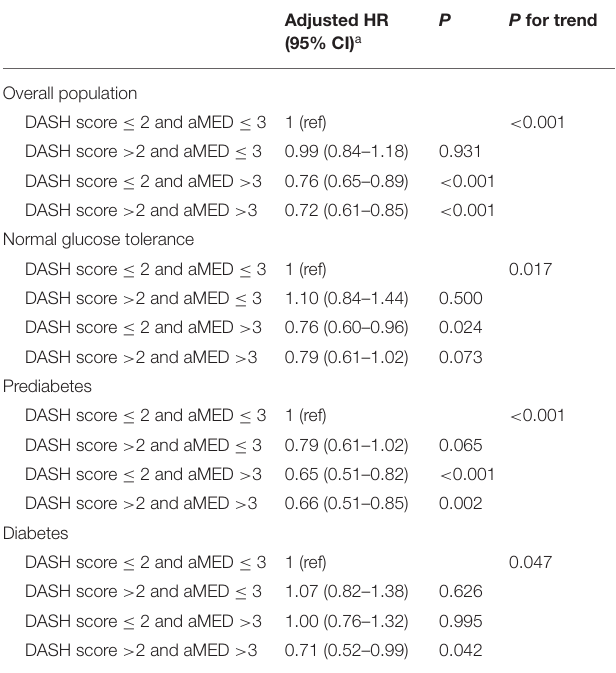
TABLE 3 | Associations of adherence to DASH and Mediterranean diet with all-cause and CV mortality.